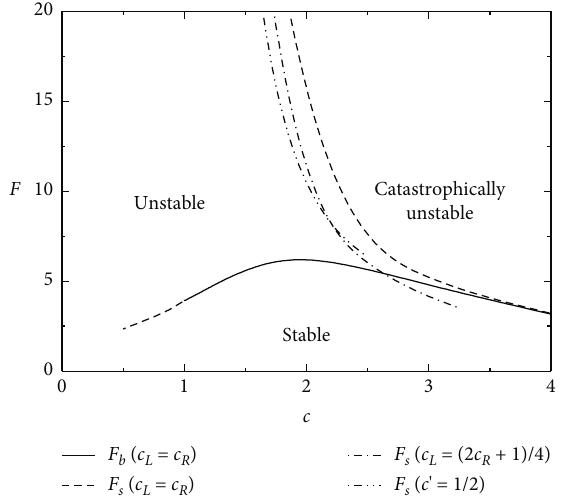
Figure 9: Illustration of the (a) asymmetric condition with c (b) symmetric condition; and (c) asymmetric condition with c L � (2 c R +1)/4.